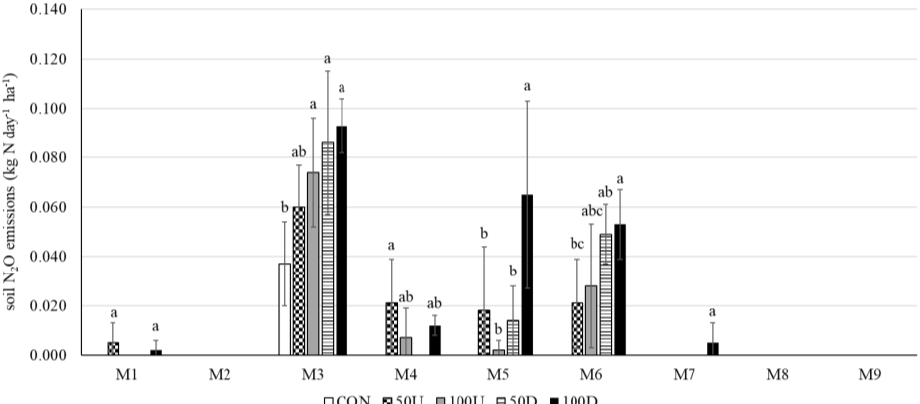
Figure 5. N 2 O emission fluxes (kg N day −1 ha −1 ) during the growing cycle for the control (CON), urea 50 kg N ha −1 (50U), urea 100 kg N ha −1 (100U), digestate 50 kg N ha −1 (50D), and digestate 100 kg N ha −1 (100D). Results that do not share letters are significantly different from each other ( p < 0.05).